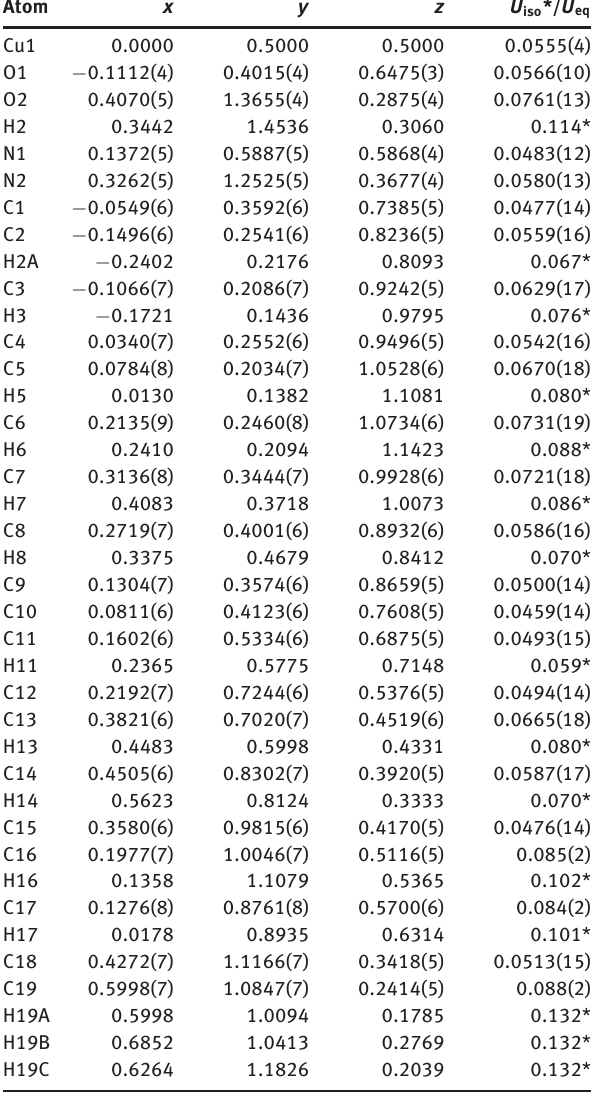
Table 2: Fractional atomic coordinates and isotropic or equivalent isotropic displacement parameters (Å 2